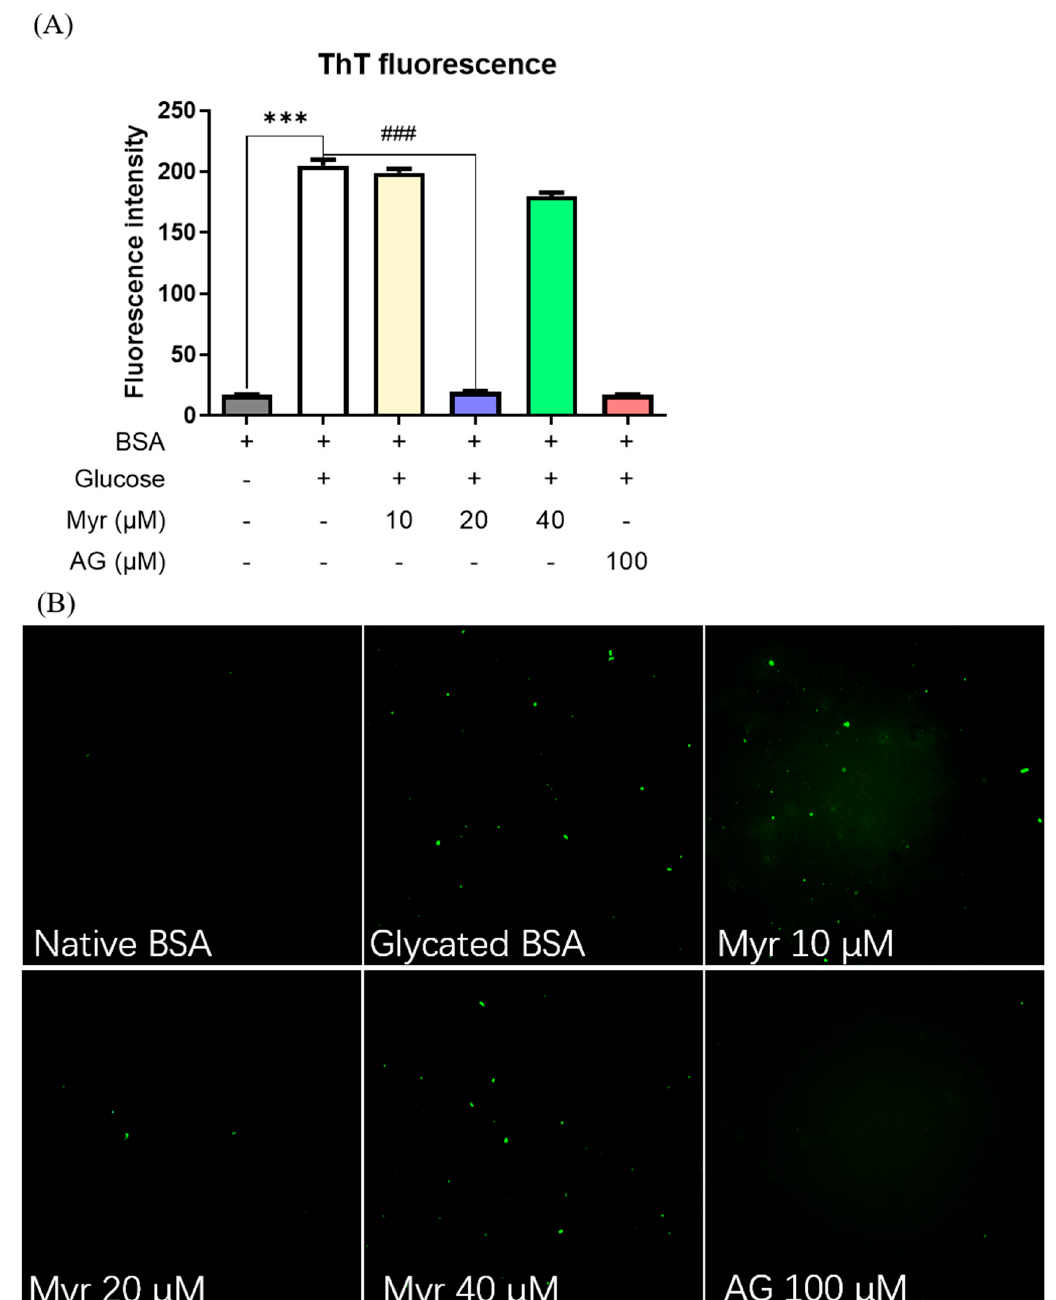
Figure 2. Effects of Myr on glycation-induced protein amyloid aggregation. ( A ) ThT fluorescence spectrometry analysis of amyloid-like fibrils in the presence and absence of Myr or AG (aminoguanidine, positive control). ( B ) The fluorescence microscopy analysis of amyloid-like fibrils in the absence and presence of Myr. *** p < 0.001 compared with native BSA. ### p < 0.001 compared with glycated BSA.